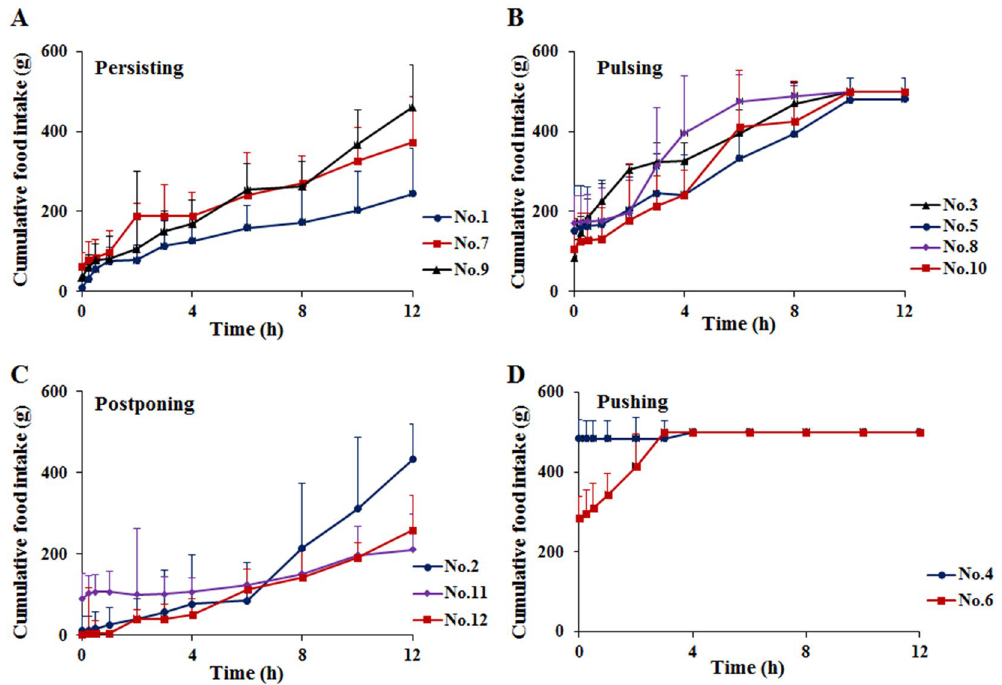
Figure 1. Four types of food taking were identified and named as Persisting, continuous slow food intake within 12 h. ( A ) Pulsing, taking food in particular periods. ( B ) Postponing, taking little or no food at the beginning ( C ) and Pushing, finishing the food completely in the first 4 h ( D ). All the data were mean ±